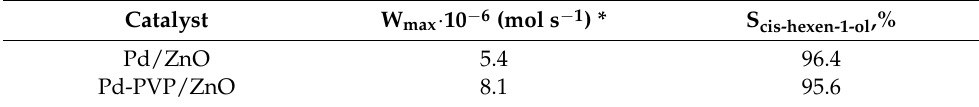
Table 4. Results of hydrogenation of 2-hexynol-1 in ethanol on the 0.5% palladium catalysts.